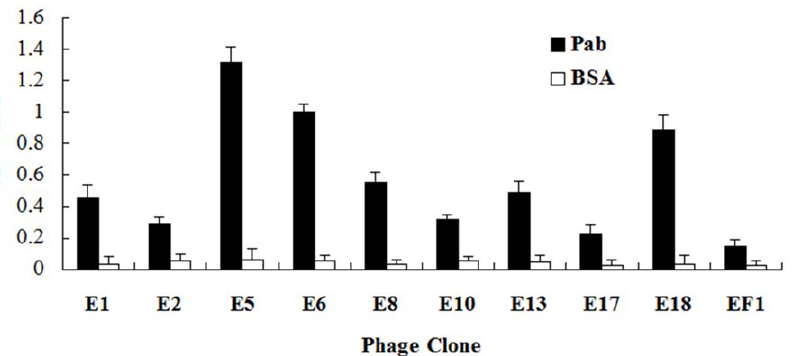
Figure 3. ELISA immunoreactivity of selected phage clones against anti-CE polyclonal antibodies (pAbs) or BSA (control). Nine phage clones with different peptide sequences were used for the phage ELISA analysis. Phage clones were added to the plates coated with either pAbs or BSA. Capture of the phages by antibodies was detected with anti-M13 mAb conjugated to horseradish peroxidase using tetramethylbenzidine as a substrate. The reaction was read at 460 and 620 nm. The data represent the mean and standard deviation of triplicate wells. The first eluted phage library (EF1) was used as negative control. PBST (B) was used as blank control. Phage clones E5, E6 and E18 showed more than 4 times higher affinity to anti-CE pAbs, and E1, E8 and E13 also showed more than 3 times higher affinity, all of which should be positive clones.